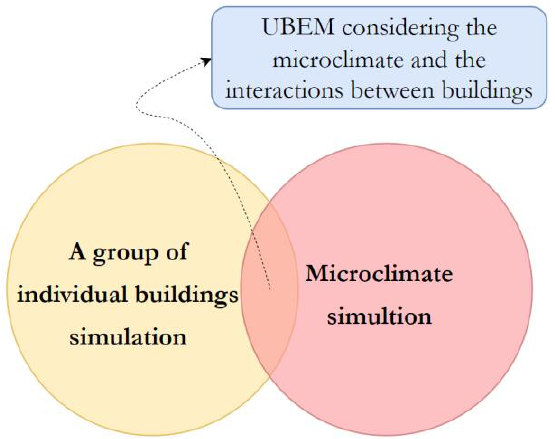
Figure 6. Two distinct areas of study in urban building energy modeling.